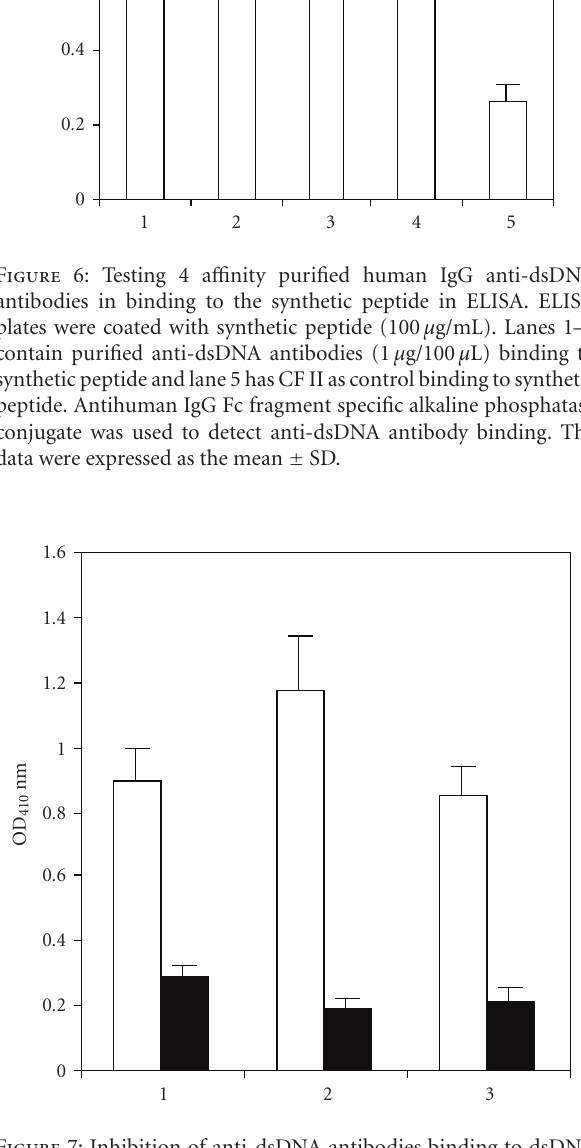
Figure 7: Inhibition of anti-dsDNA antibodies binding to dsDNA antigen by synthetic peptide (RAGTDEGFG). ELISA plates were coated with dsDNA (50 μ g/mL). Lane 1, 2, and 3 are three di ff erent patients anti-dsDNA antibodies. The light column shows the patient purified anti-dsDNA antibodies (1.25 μ g/100 uL) bind to dsDNA antigen, and dark column shows the patient purified anti- dsDNA antibodies (1.25 μ g/100 uL) mixed with synthetic peptide (3.4 μ g/100uL). The data were expressed as the mean ±